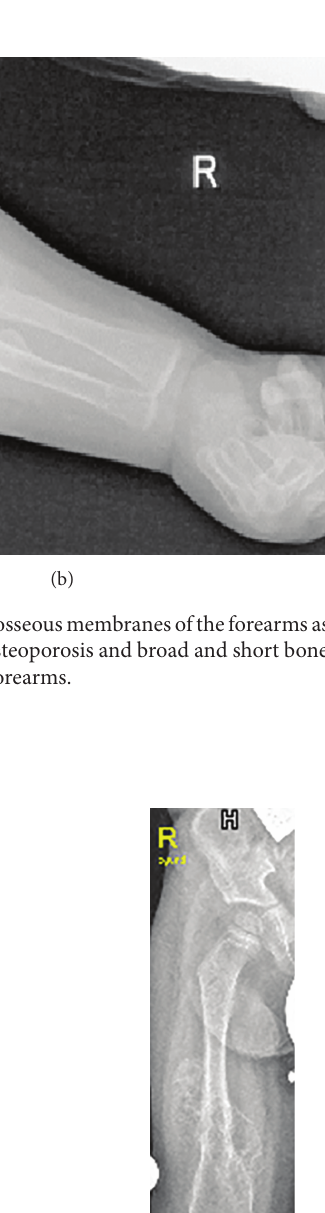
Figure 4: Anteroposterior pelvic and femora radiograph showed dysplastic ischium, short femora, and broad particularly over the distal parts. Calcification of the interosseous membrane was appar- ent bilaterally associated with overwhelming osteoporosis and the presence of a radiodense band visualized at the growth plate. Figure 5: Supracondylar femoral fracture in the same patient at the age of 3 years note the profound development of callus around the lower third of the shaft of the femur. This feature looks to be a characteristic finding in patients with OI type